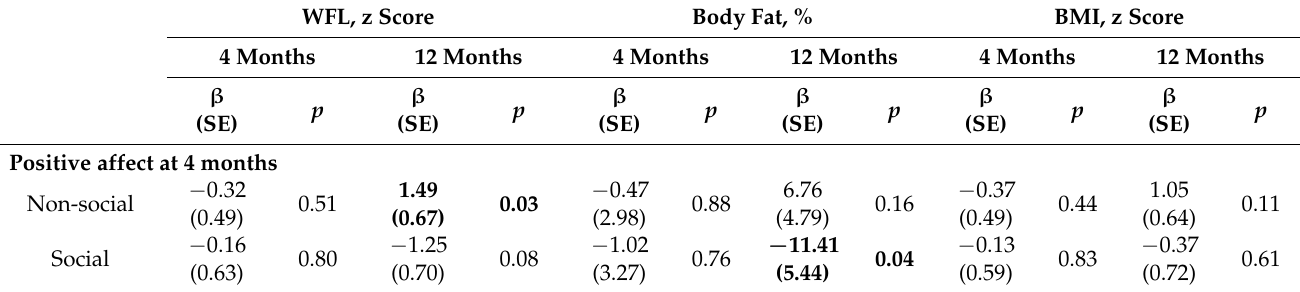
Table 2. Parameter estimates from multi-level linear regressions examining associations between social and non-social positive affect (independent variable) with standardized weight-for-length (zWFL), body fat percentage, and standardized body mass index (zBMI) (dependent variables) across